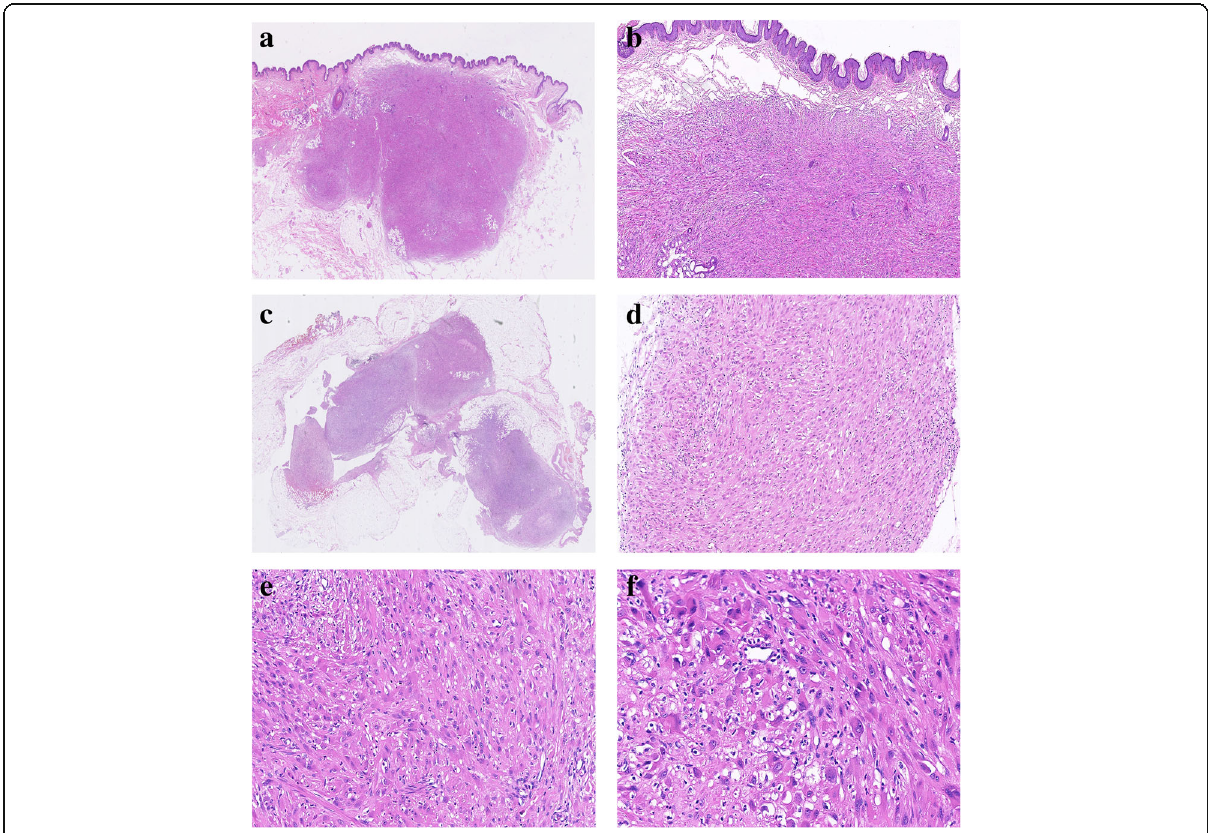
Fig. 1 Scanning image of “ mass of right labium majus (epidermis) ” displayed a vague nodular appearance of the tumor ( a ), which was mainly dermal-based ( b ). Scanning image of “ mass of right labium majus (deep) ” showed a subcutaneously located tumor with multinodular architecture ( c ). The tumor was composed of fascicles of plump spindled to epithelioid cells with abundant eosinophilic cytoplasm ( d ), some of which resembled rhabdomyoblasts ( e ). Focal storiform arrangement was present and scattered neutrophilic infiltrate was observed in the stroma ( f